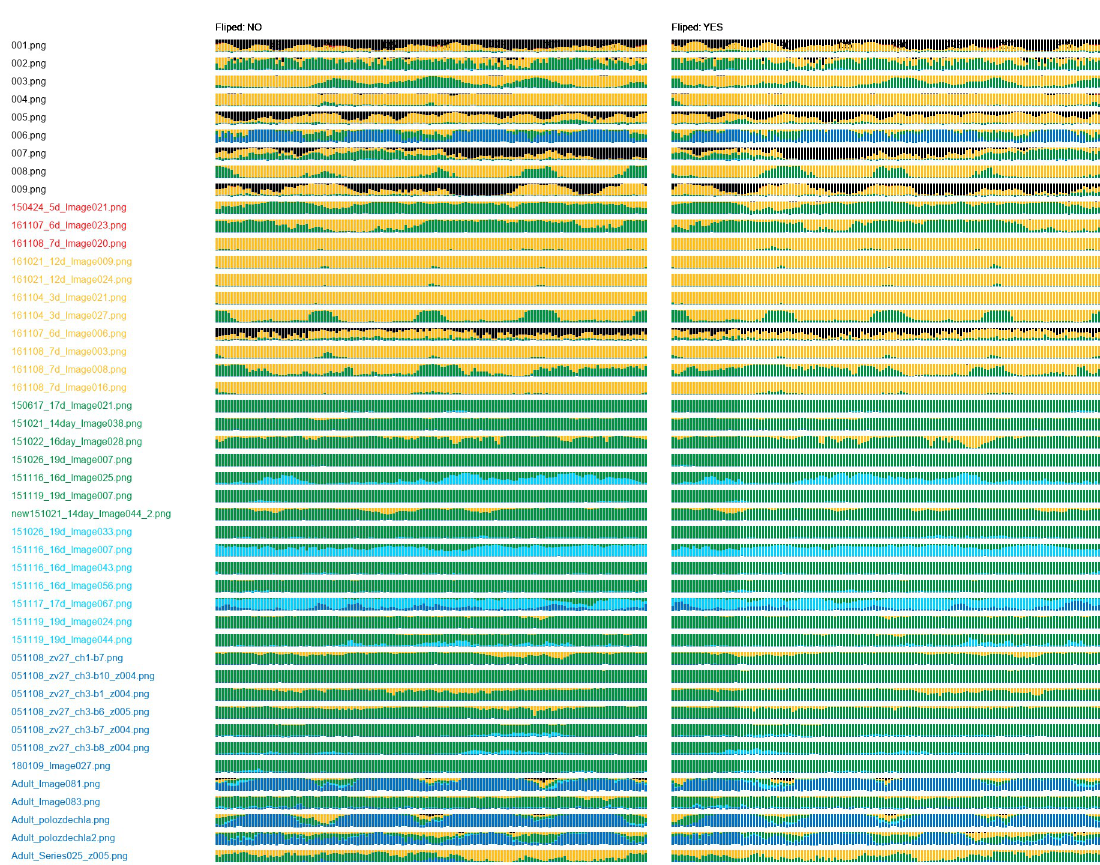
Fig 7. Class probability graph obtained for the DenseNet-512 trained on T-512-A. The trained network assigns most of the samples either to the class 2 or 3. Classes 0, 1 and 5 not recognized at all.